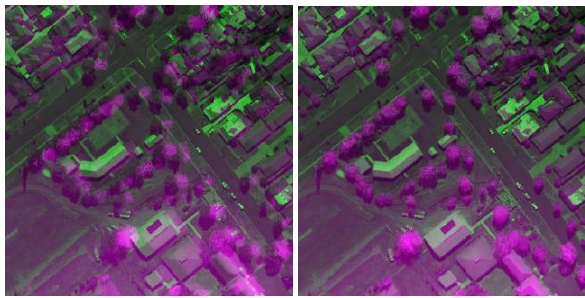
Figure 5. Unregistered (left) and registered (right) aerial image (green) with LiDAR DSM (magenta)